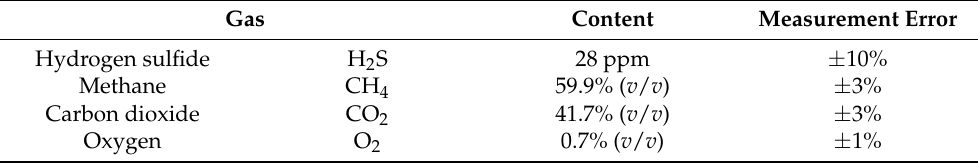
Table 5. Chemical composition of biogas.